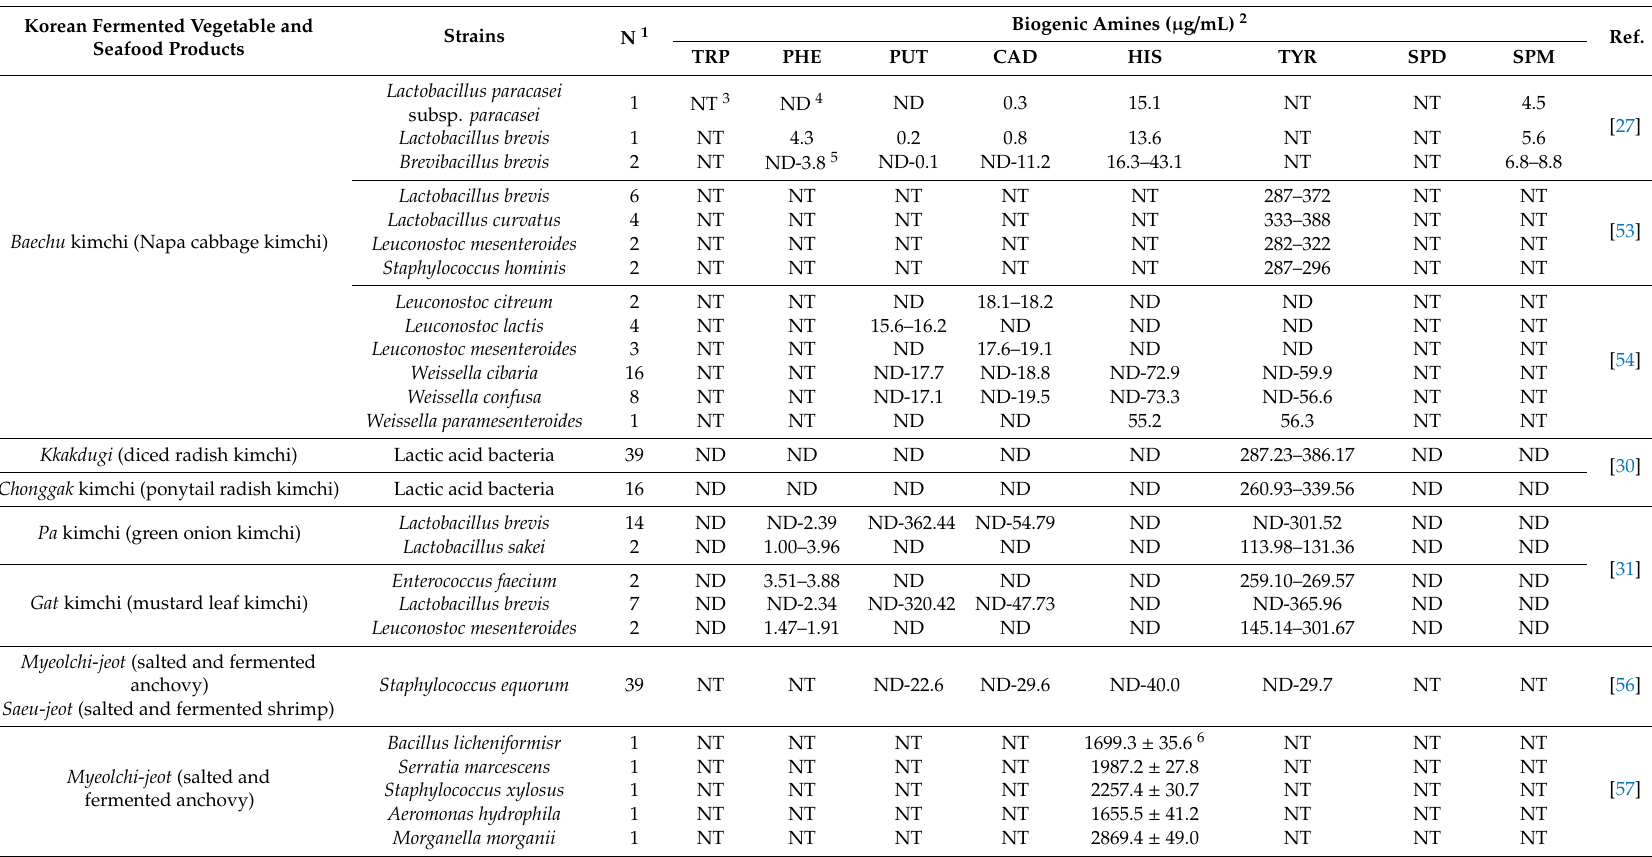
Table 3. Biogenic amine production by bacterial strains isolated from Korean fermented vegetable and seafood